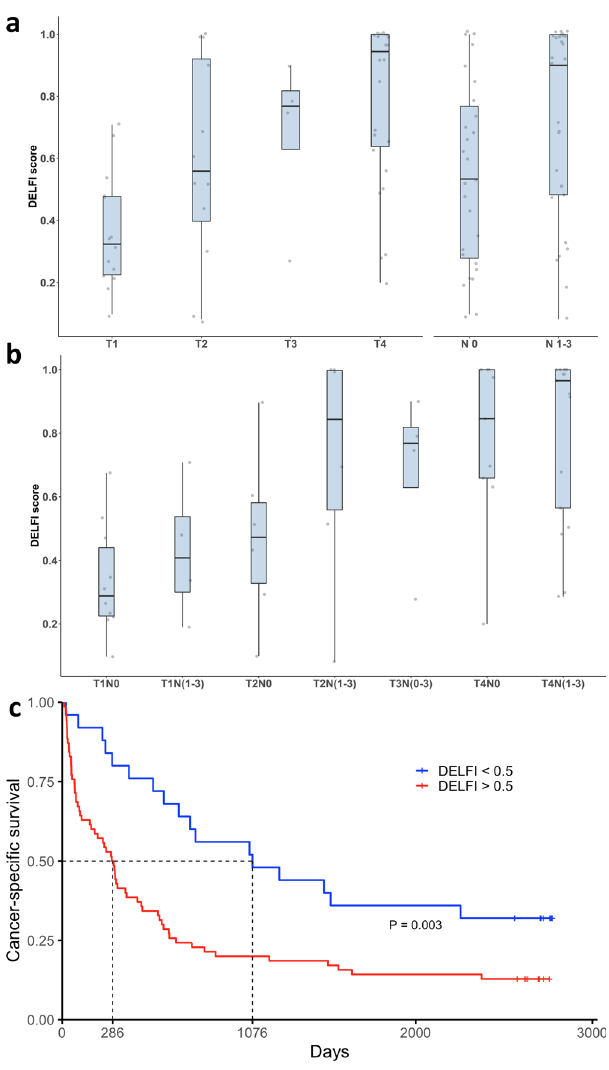
Fig. 4 Relationship of size and invasiveness of lung cancer with DELFI score. a DELFI scores of non-metastatic patients with lung cancer categorized by T stage or N stage in the LUCAS cohort. We observe an incremental increase of the DELFI score by T stage from T1 to T4 ( p < 0.01, Kruskal – Wallis, df = 3, two-sided) ( n : T1 = 14, T2 = 12, T3 = 4, T4 = 26). Lung cancer patients without involvement of lymph nodes had a signi fi cantly lower DELFI scores compared to patients with nodal spread (Wilcoxon rank sum test, p < 0.001, two-sided) ( n : N0 = 27, N 1 – 3 = 29). b The stepwise increase in DELFI score by T and N stage was maintained